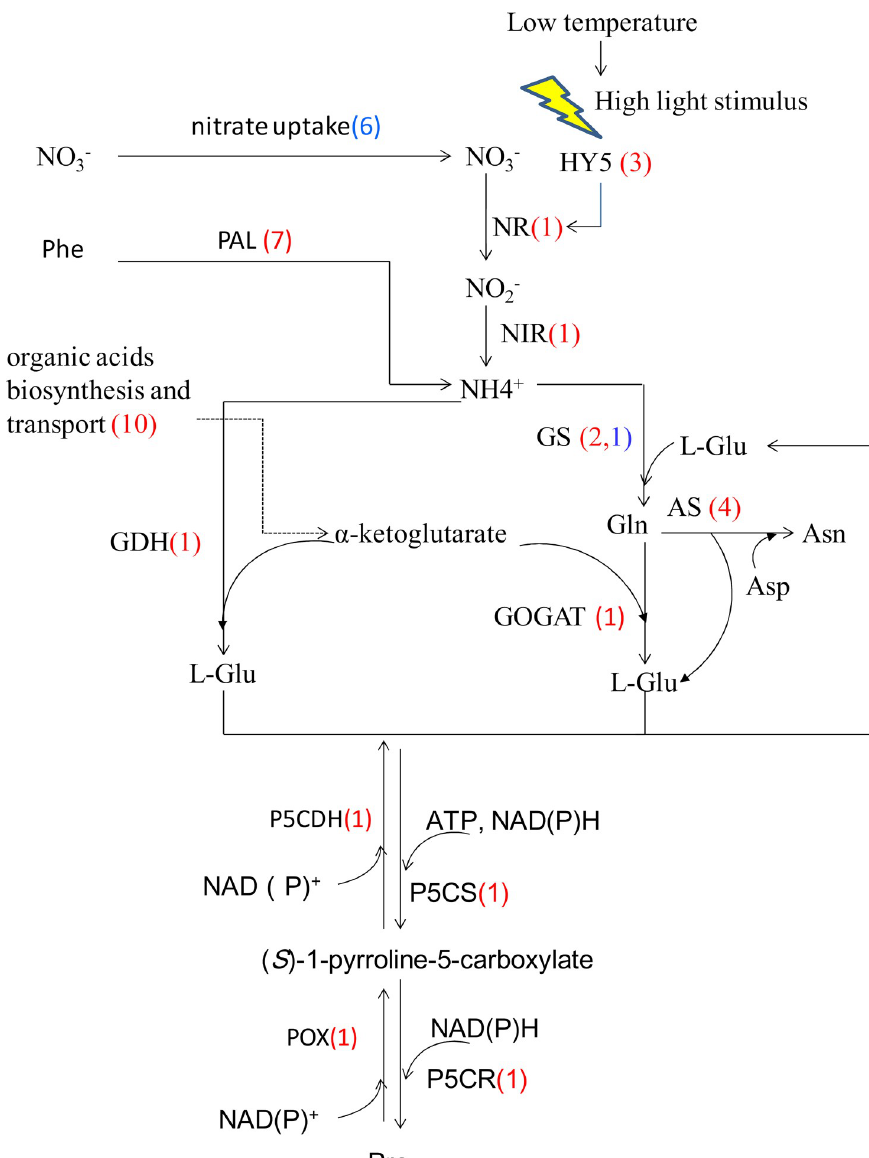
Fig 9. DEGs involved in nitrogen assimilation. Phe: phenylalanine; PAL:phenylalanine ammonia-lyase; HY5: Transcription factor long hypocotyl 5; NR: Nitrate reductase; NIR: Ferredoxin—nitrite reductase; GS: Glutamine synthetase; AS:Asparagine synthetase; GOGAT: glutamate synthase; GDH: Glutamate dehydrogenase; P5CS:Delta 1-pyrroline-5-carboxylate synthetase; P5CR: Pyrroline-5-carboxylate reductase; POX: Proline dehydrogenase; P5CDH: Delta-1-pyrroline-5-carboxylate dehydrogenase. In brackets, red numbers represent the number of up-regulated unigenes, blue numbers represent the number of down-regulated unigenes, the same below. / glutamate synthase (GS/GOGAT) cycle [65]. Manila grass exposed to cold stress for 72h modulated the expression of multiple genes involved in nitrogen metabolism (Fig 9, S11 Table). At the 72h-cold point, six DEGs involved in the uptake of nitrate, including five of NRT1/ PTR (nitrate transporter 1/peptide transporter) family and one of chloride channel (CLC) fam- ily, were down-regulated. A study of Arabidopsis indicated that the expression of NRT1.5 was